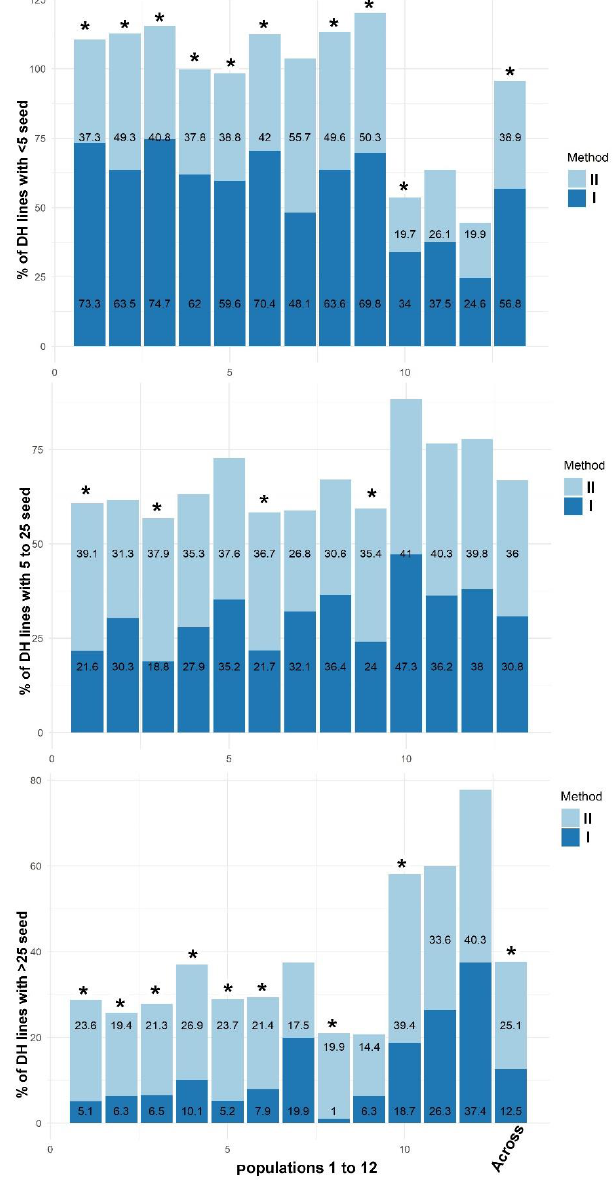
Figure 1. Comparison of seed quantity among D 1 ears generated by using Method II vs. Method I. In the graphs, * indicates statically significant differences among the two methods tested for proportion of doubled haploids (DH) lines in each category.